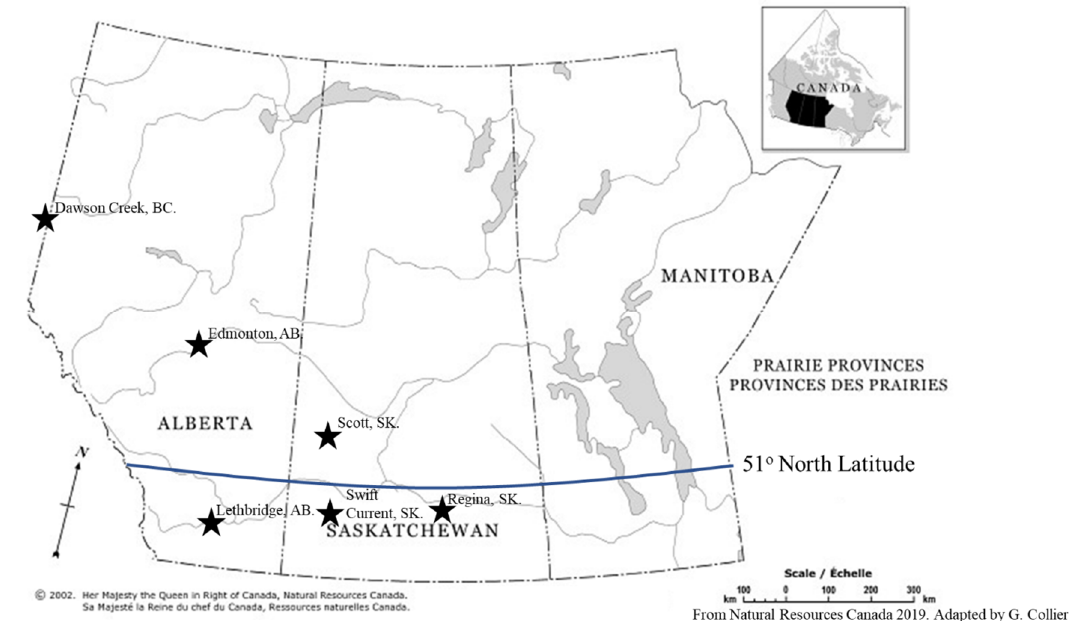
Figure 1. Geographical distribution of test locations for the assessment of planting date, rate, depth and wheat line on ultra-early wheat seeding systems on the northern Great Plains. (The Atlas of Canada—Natural Resources Canada. http://ftp.geogratis.gc.ca/pub/nrcan_rncan/raster/atlas_6_ed/reference/bilingual/prairies_out.jpg). Adapted from Collier et al. [8].